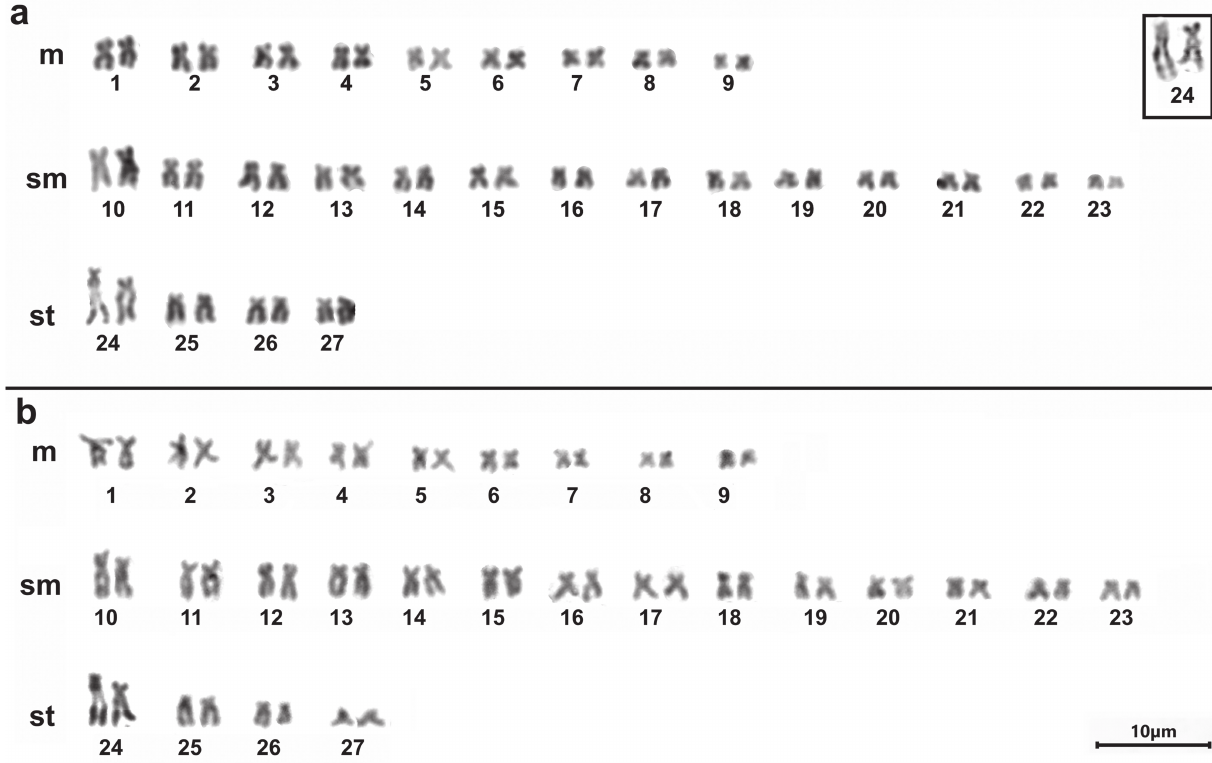
Fig. 3. Karyotypes stained with Giemsa (a) and C-banding (b) of Otothyropsis cf. polyodon from the córrego Dourado. Box: pair 24, bearing the